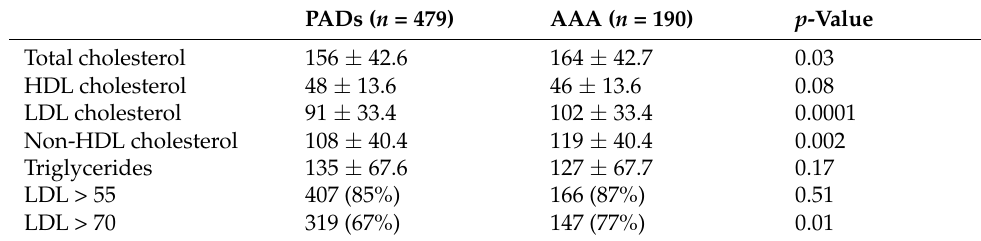
Figure 1. Low-density lipoproteins profile in PAD vs. AAA patients. Table 2. Lipid profile in the study